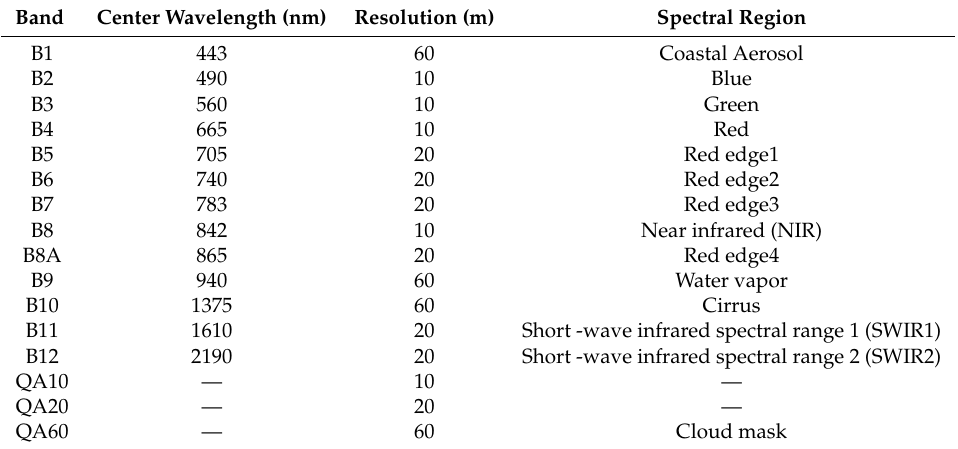
Table 1. Spectral bands of the Sentinel-2 imagery.